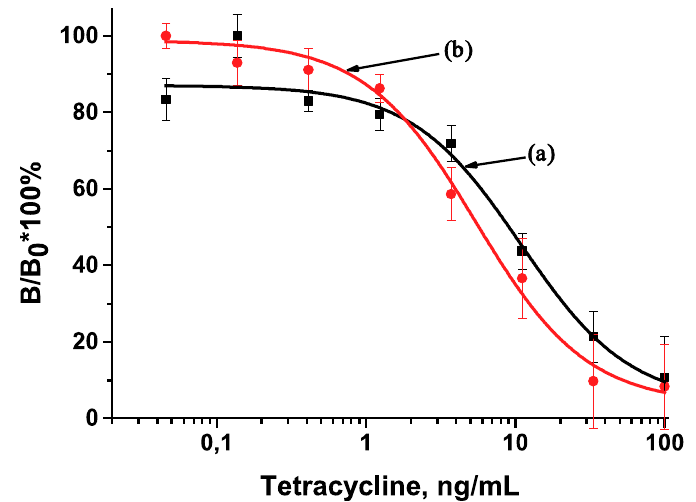
Figure 4. Calibration curves for the tetracycline determination by the developed ICA with direct antibodies labeling: (a) in undiluted serum (y = 4.03194 + (87.06987 − 4.03194)/(1 + (x/10.87484) 1.1857 ), R 2 = 0.97758); (b) in twice-diluted serum (y = 3.75211 + (98.79633 − 3.75211)/(1 + (x/5.44732) 1.17032 ), R 2 = 0.92389).